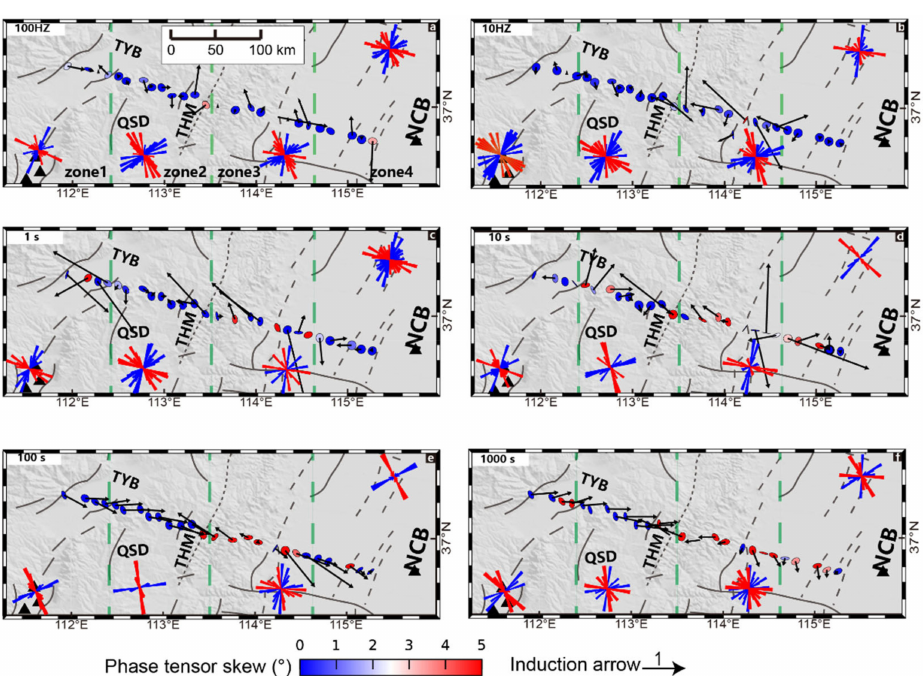
Figure 3. Geoelectric strike direction, phase tensor and real induction arrows for different period bands. Strike directions are shown as rose diagrams for three different zones of MT sites according to geographical locations, with red-blue sectors illustrating the inherent 90 ◦ ambiguity. Phase tensor ellipses are shaded according to skew value β . The induction vectors are plotted in the Parkinson convention, pointing towards conductors. The superposed tectonic features are the same as those in Figure